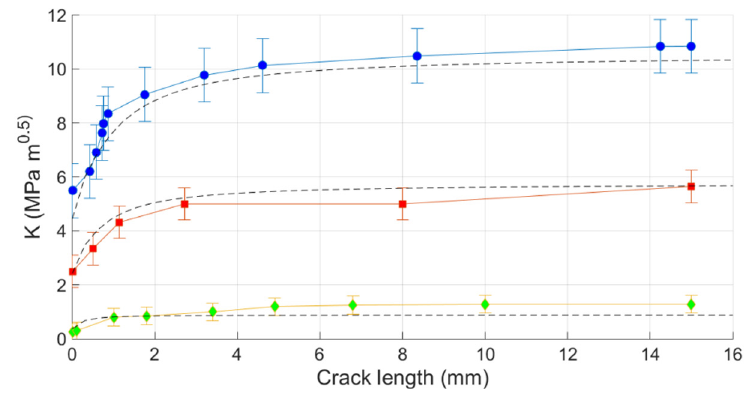
Figure 3. R-curve behaviour of 3YSZ samples with different porosity (p) values (standard deviation is also plotted). Dotted lines represent a family of curves of K I versus porosity obtained from Equation (5).